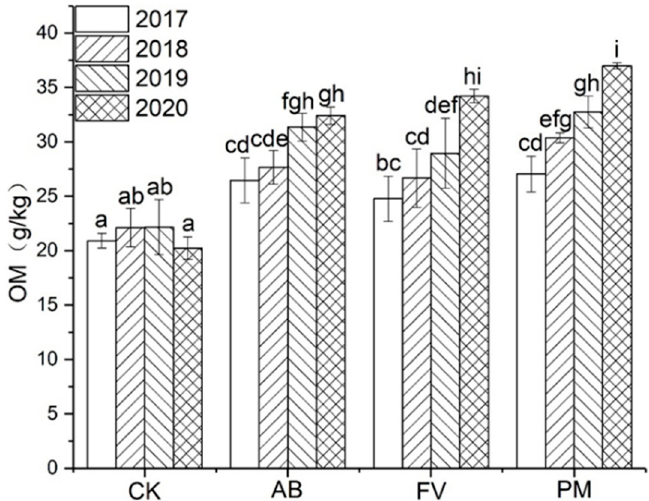
Figure 1. Effects of the different fertilizer treatments on the content of OM in the soils. All the data are expressed as means ± SD; n = 3. Different letters on data in the same group indicate a significant difference between them at p < 0.05 level.